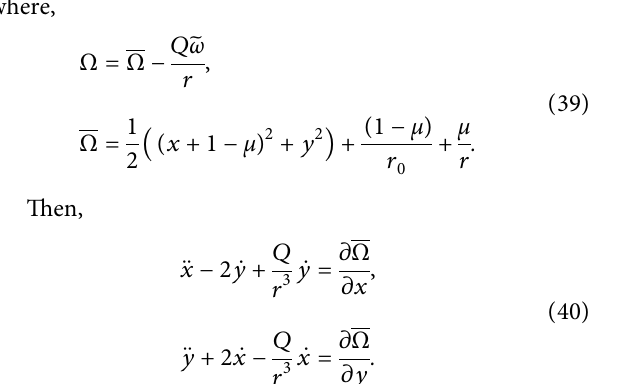
4 distance with Jupiter from r